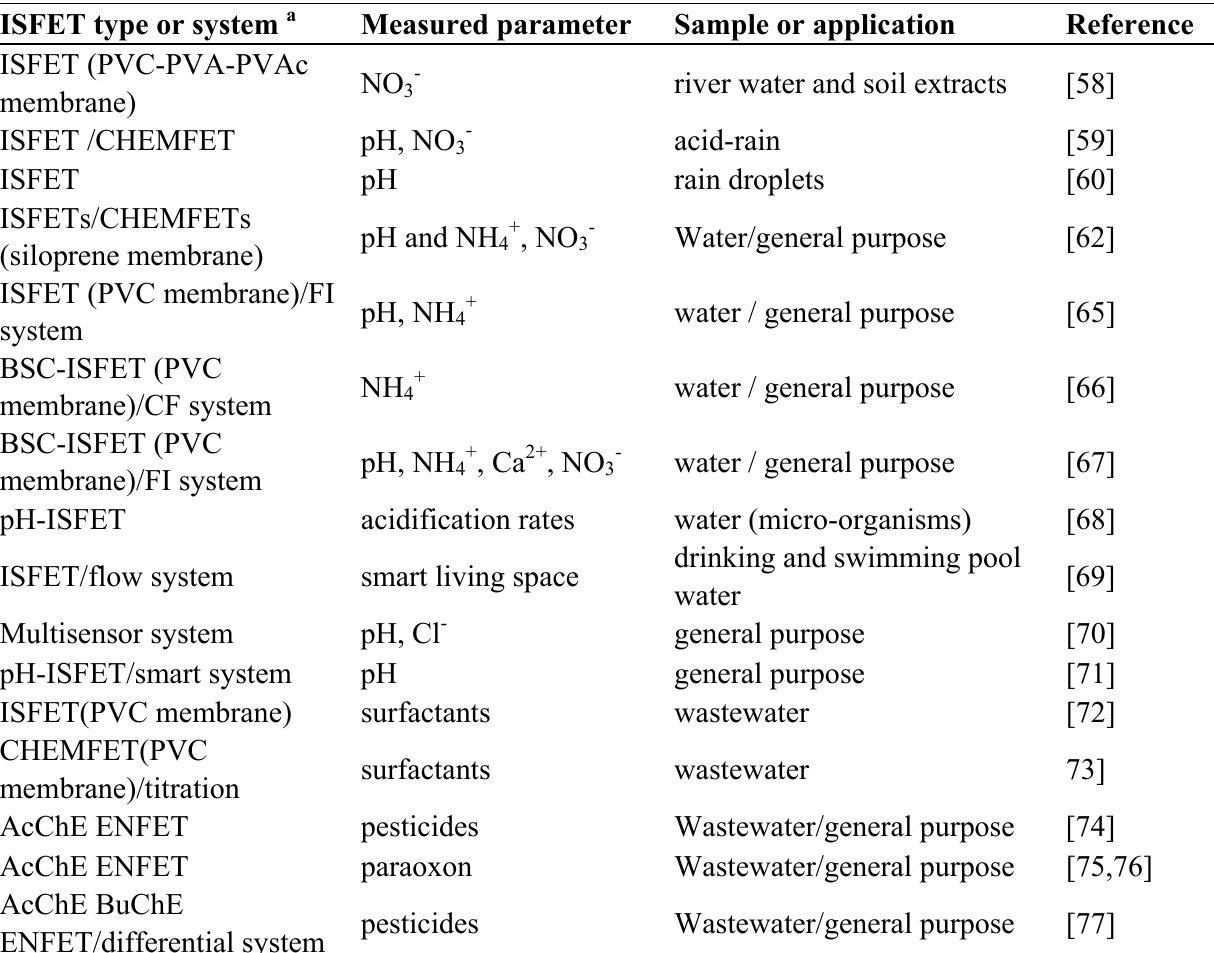
Table 2. Summary of ISFETs applied in the environmental